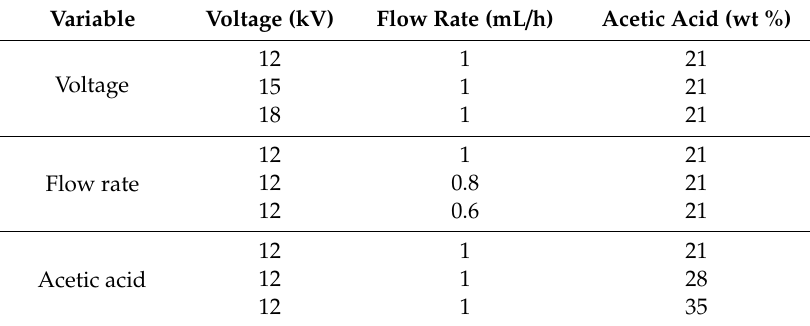
Figure 1. Schematic diagram of electrospinning process. Table 1. Process variables of electrospinning for TiO 2 / ZnO nanofibers.